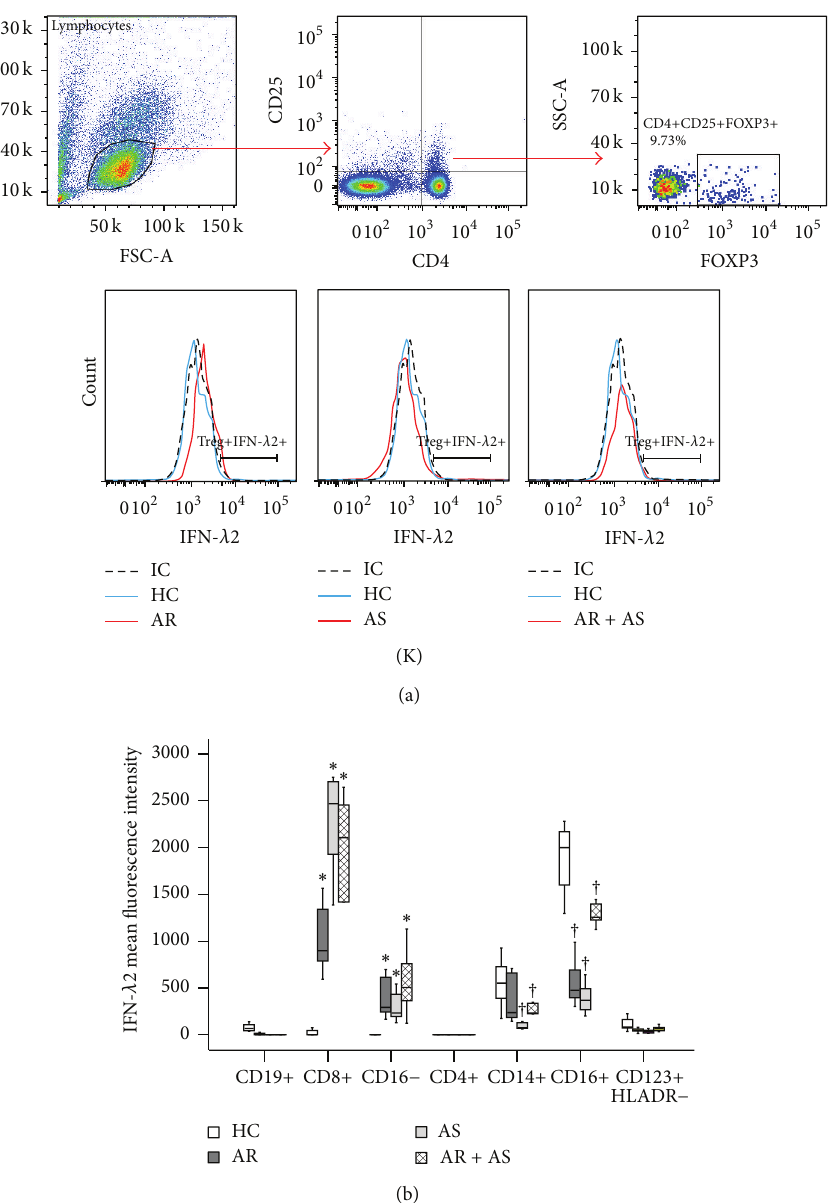
Figure 2: Flow cytometry analysis of the expression of IFN- 𝜆 2 in peripheral blood leukocytes. (a) (A), (B), (C), (D), (E), (F), (G), (H), (I), (J), and (K) showed a representative graph of the changes in mean fluorescent intensity in CD19+ cells (B cells), CD8+ cells (cytotoxic T cells), CD16 − polynucleated cells (eosinophils), CD4+ cells (helper T cells), CD14+ cells (monocytes), CD16+ cells (neutrophils), CD123+HLA-DR − cells, CD4+INF- 𝛾 + cells (Th1 cells), CD4+IL-4+ cells (Th2 cells), CD4+IL-17A+ cells (Th17 cells), and CD4+CD25+FOXP3+ cells (regulatory T cells) in allergic rhinitis (AR), asthma (AS), and combined AR and AS (AR + AS) and healthy control subjects (HC), respectively. IC = isotype control. (b) represents boxplot analysis of the expression of IFN- 𝜆 2 in peripheral blood leukocytes. Data are displayed as a boxplot for AR ( 𝑛 = 33 ), AS ( 𝑛 = 26 ), AR + AS ( 𝑛 = 12 ), and HC ( 𝑛 = 20 ), which indicates the median, the interquartile range, and the largest and smallest values for the number of subjects indicated. ∗ 𝑃 < 0.05 , increased value compared with HC. † 𝑃 < 0.05 , decreased value compared with